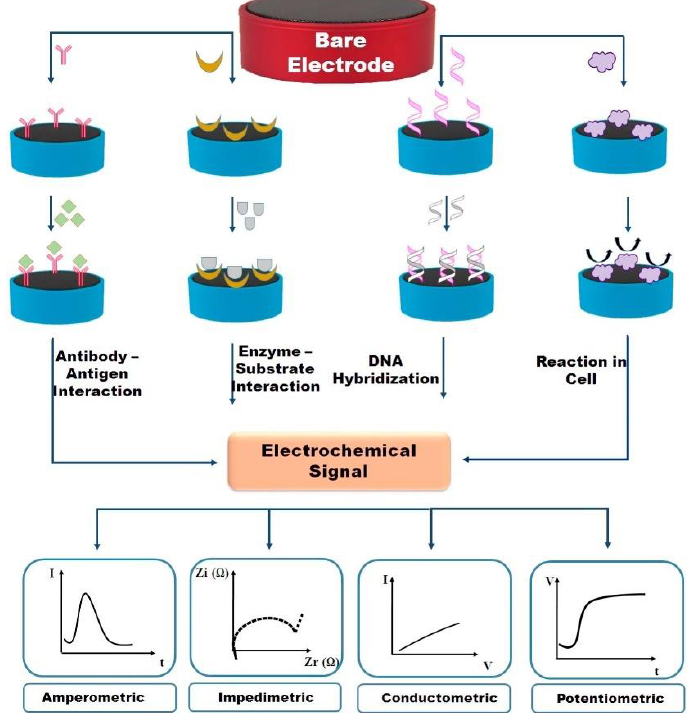
Figure 7. Typical electrochemical biosensor measurement principles. Reproduced with the permission of [166]. Copyright 2015 Published by Elsevier B.V. of [166]. Copyright 2015 Published by Elsevier